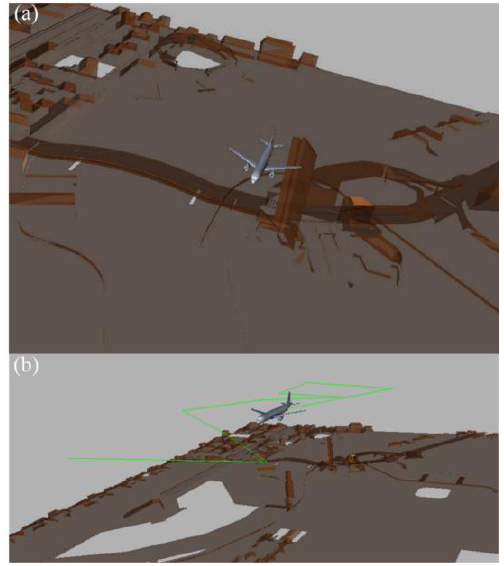
Figure 13. Real-time animation simulation: ( a ) Animated simulation of the flight in the city, ( b ) flight-trajectory display.